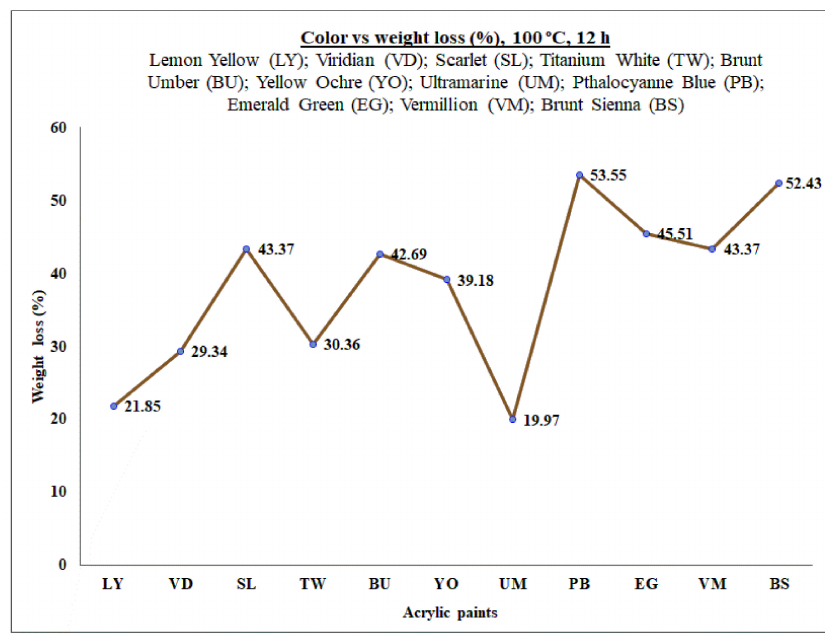
Figure 4. Color vs. weight loss of the acrylic paint